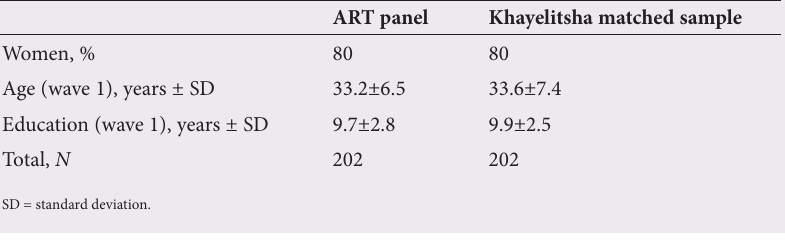
Table 2. Matched data sets